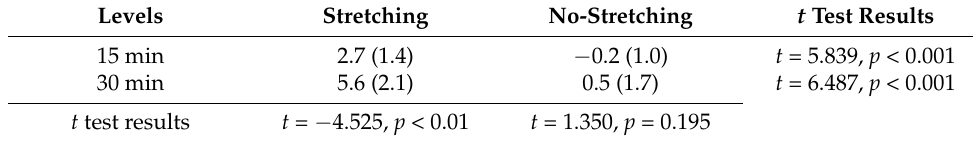
Table 2. Shank circumference reduction between various testing combinations (in mm).